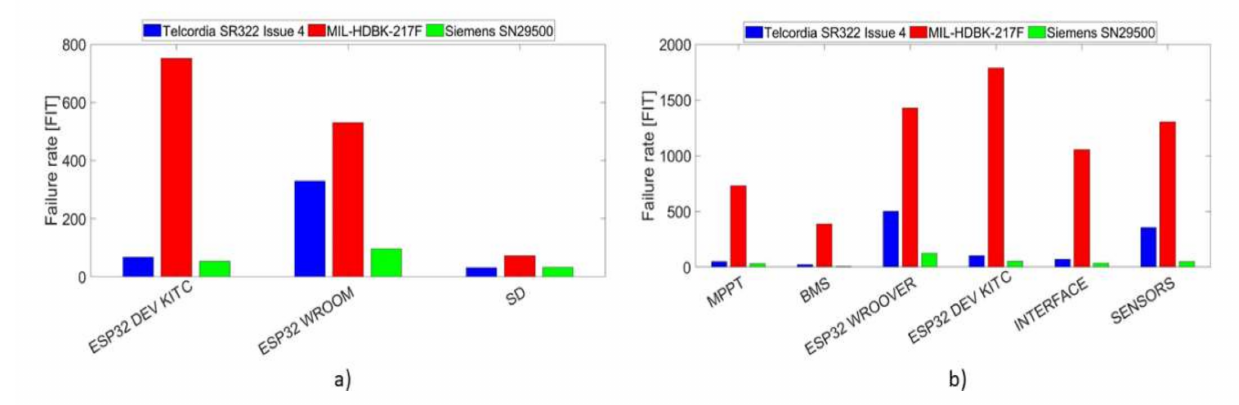
Figure 6. Comparison between failure rates of the three handbooks highlighting the subsystems that make up the nodes. The results of the root node are illustrated in the left side ( a ), while the right side ( b ) shows the failure rates that refer to the sensor node.